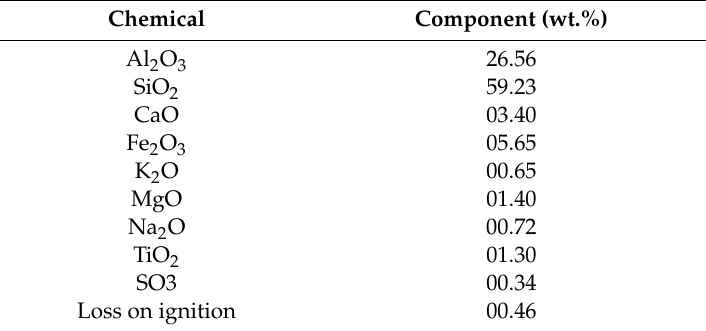
Table 1. Chemical composition of fly ash.